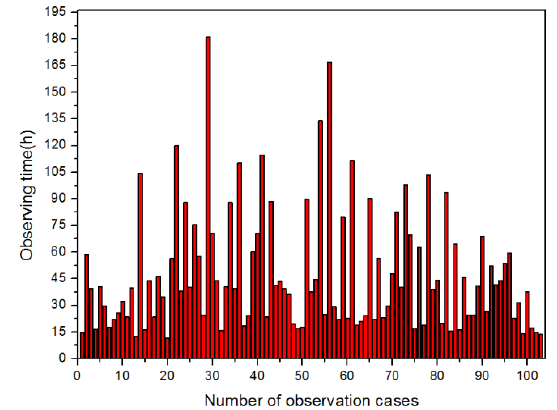
Figure 5. Statistics of continuous observation duration from April 2014 to July 2017.